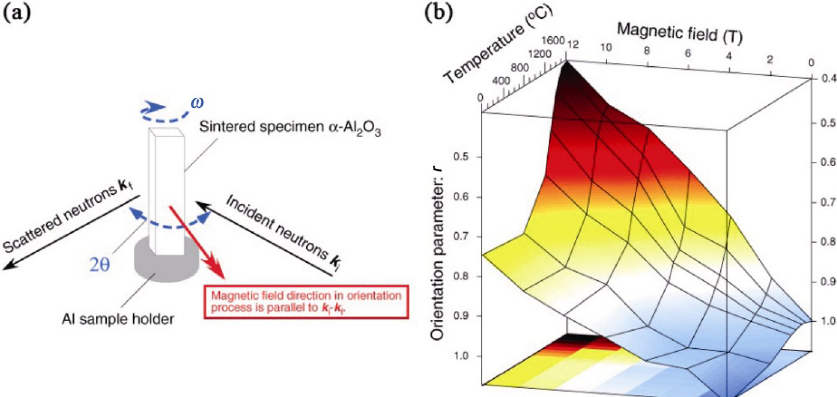
Fig. 21 Magnetic intensity and sintering temperature dependence of the orientation parameter r of the sintered α-Al 2 O 3 : (a) schematic diagram of the experimental apparatus; (b) measuring result. Reproduced with permission from Ref. [64], © IOP Publishing Ltd.